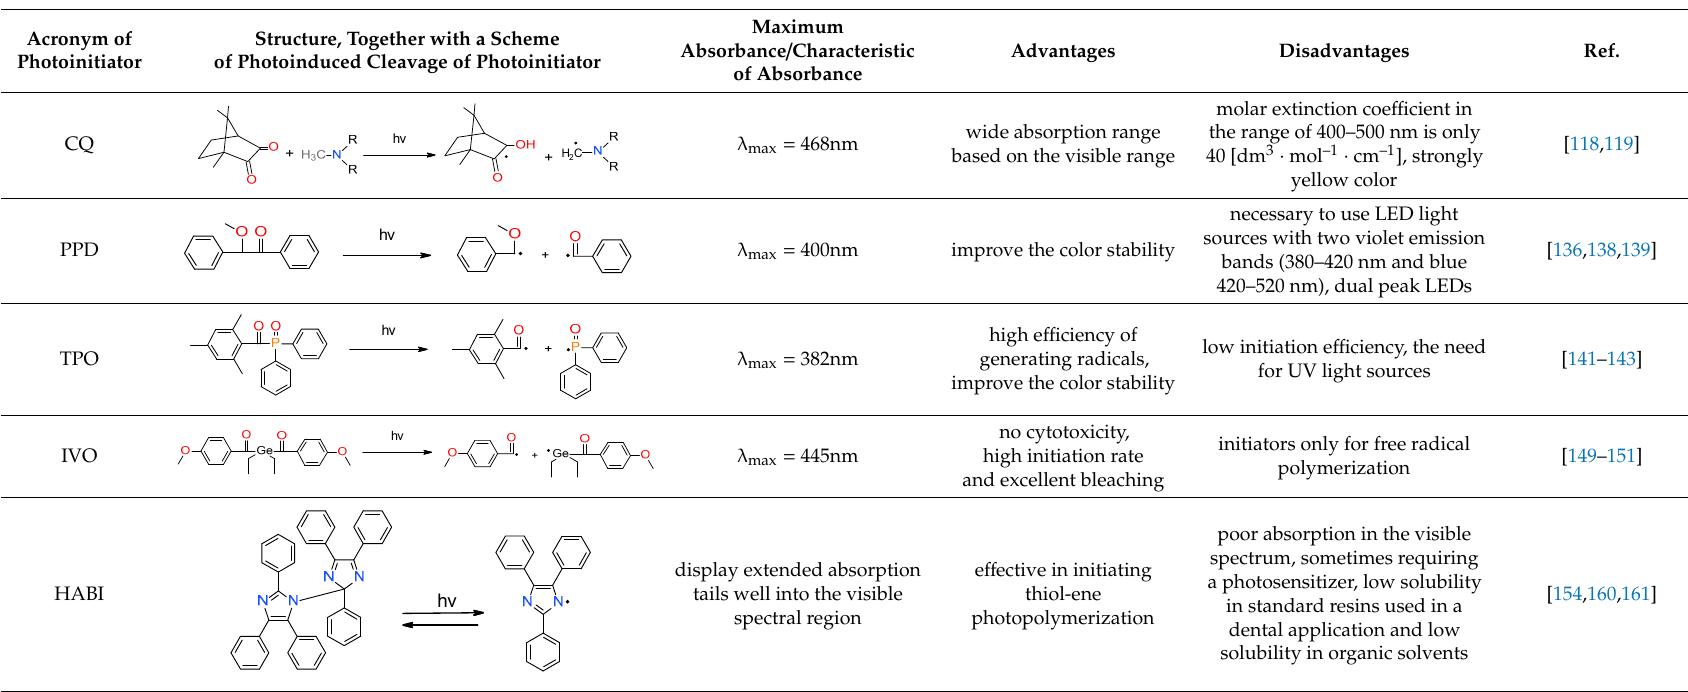
Table 2. Summary of the photoinitiators used in dental application, their basic properties, and photoinduced cleavage of photoinitiators.